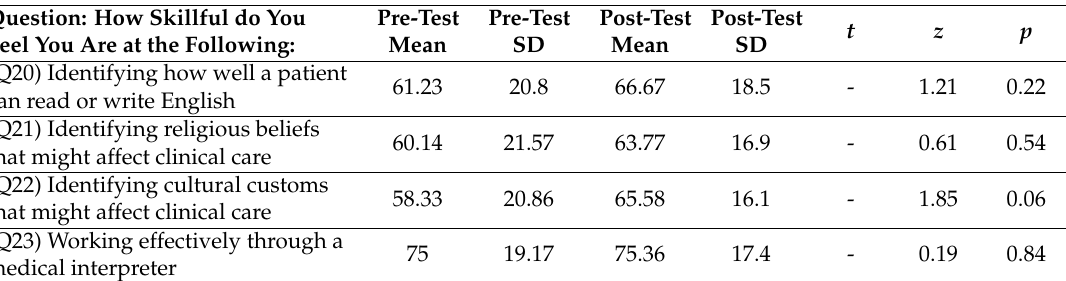
Table 5. Provider skills a,b